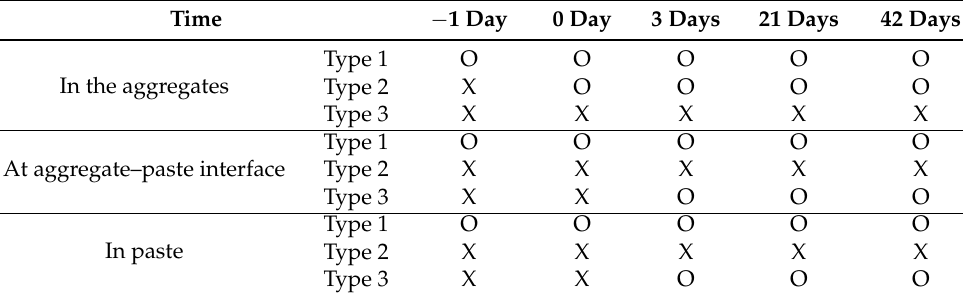
Table 5. Summary of crack types and locations at various ages.